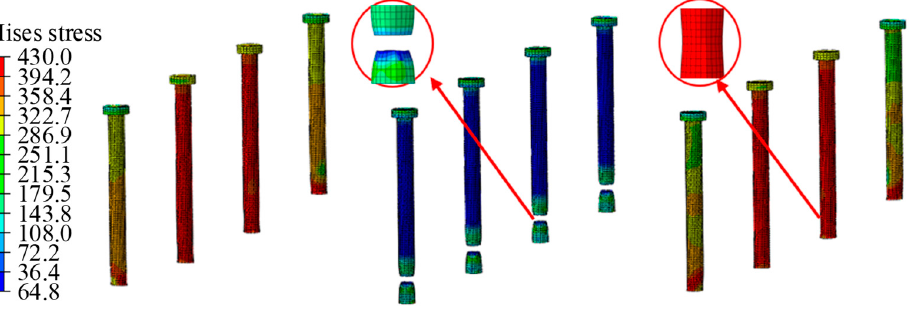
Figure 16. Mises stress of the studs in S-3 (MPa).